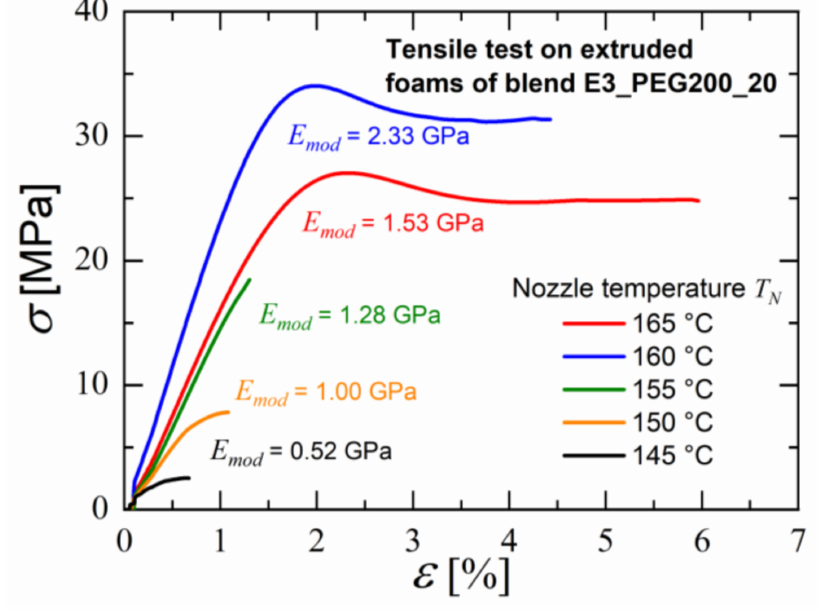
Figure 15. Tensile tests of foamed extrudates of blend E3_PEG200_20 at different nozzle temperatures during foam